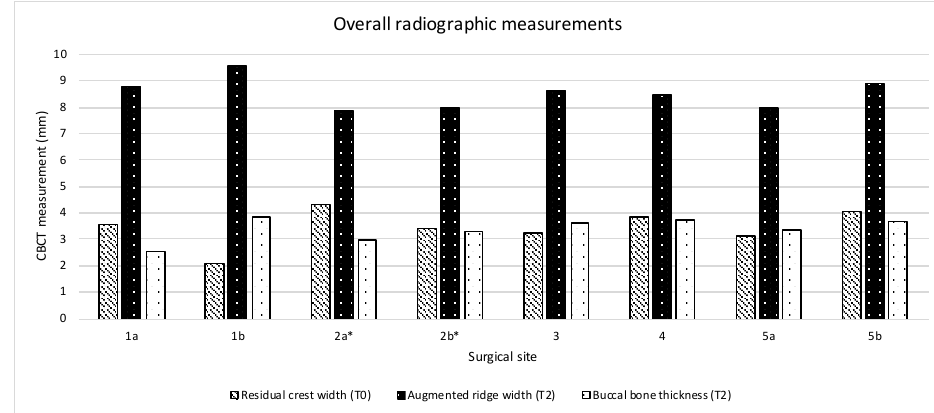
Figure 10. Graphical representation of the radiological measurements calculated at each surgical site before the surgical procedure (T0) and after 8 months (T2); *surgical site that showed membrane exposure.